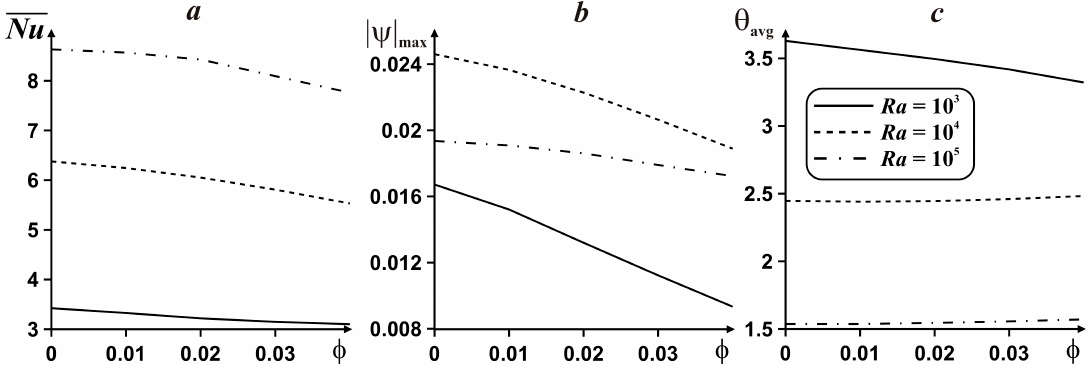
Figure 4. Dependences of the average Nusselt number ( a ), nanoliquid circulation rate ( b ) and mean heater temperature ( c ) on φ and Ra for K r = 5, δ = 0.2.